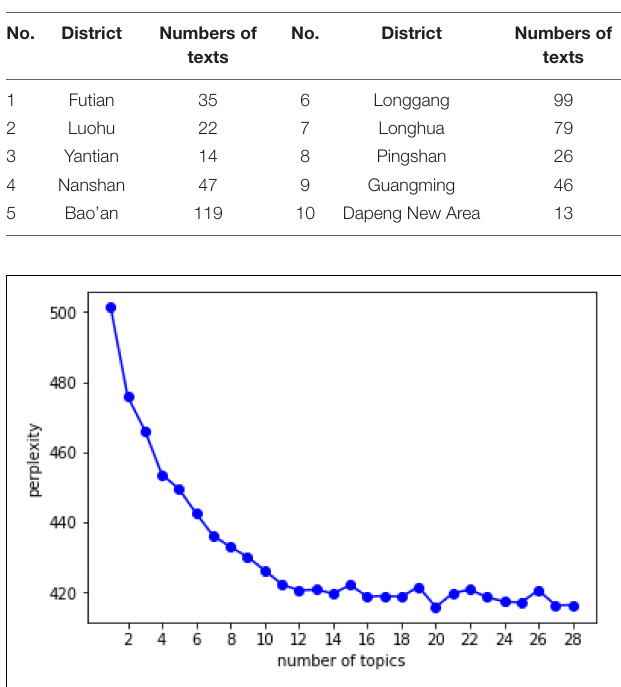
TABLE 3 | Topic extraction results of construction workers’ unsafe behavior and its influencing